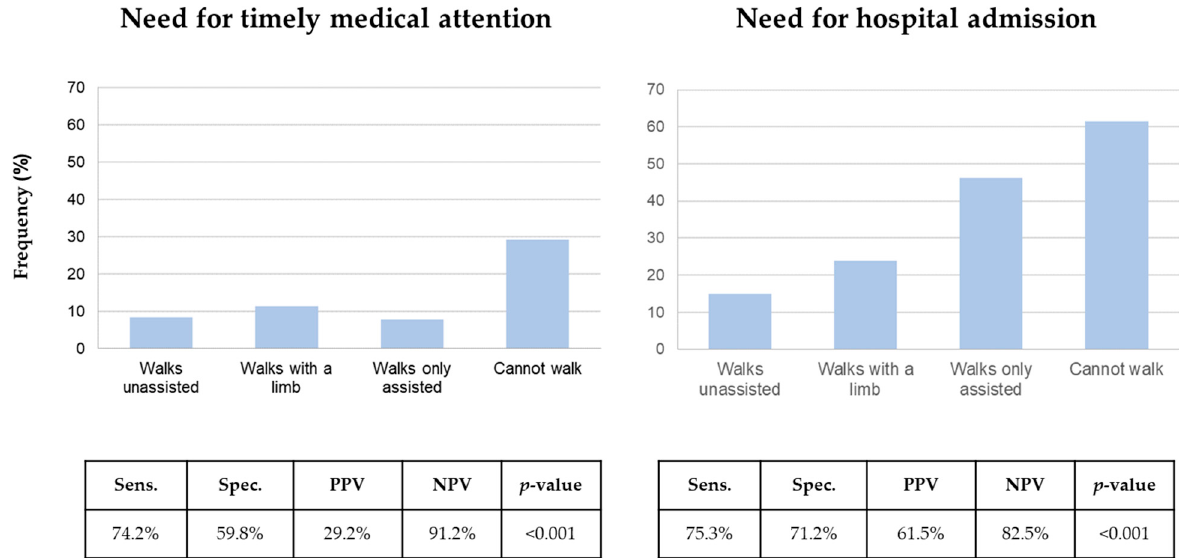
Figure 3. Frequencies of the need for timely medical attention and hospital admission depending on the ability to walk as well as the predictive value of the inability to walk at triage presentation. NPV, negative predictive value; PPV, positive predictive value; Sens., sensitivity; Spec., specificity.